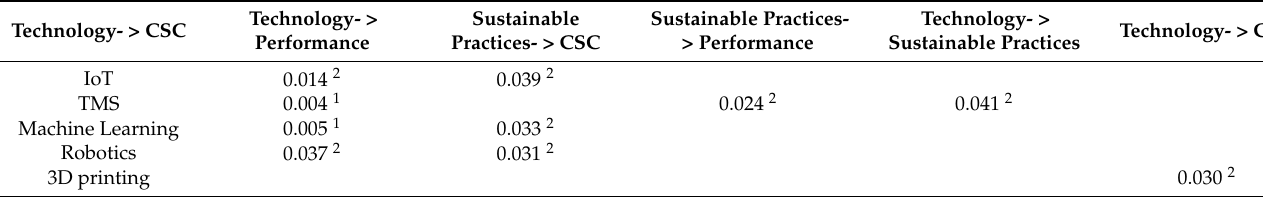
Table 5. Results of the multigroup